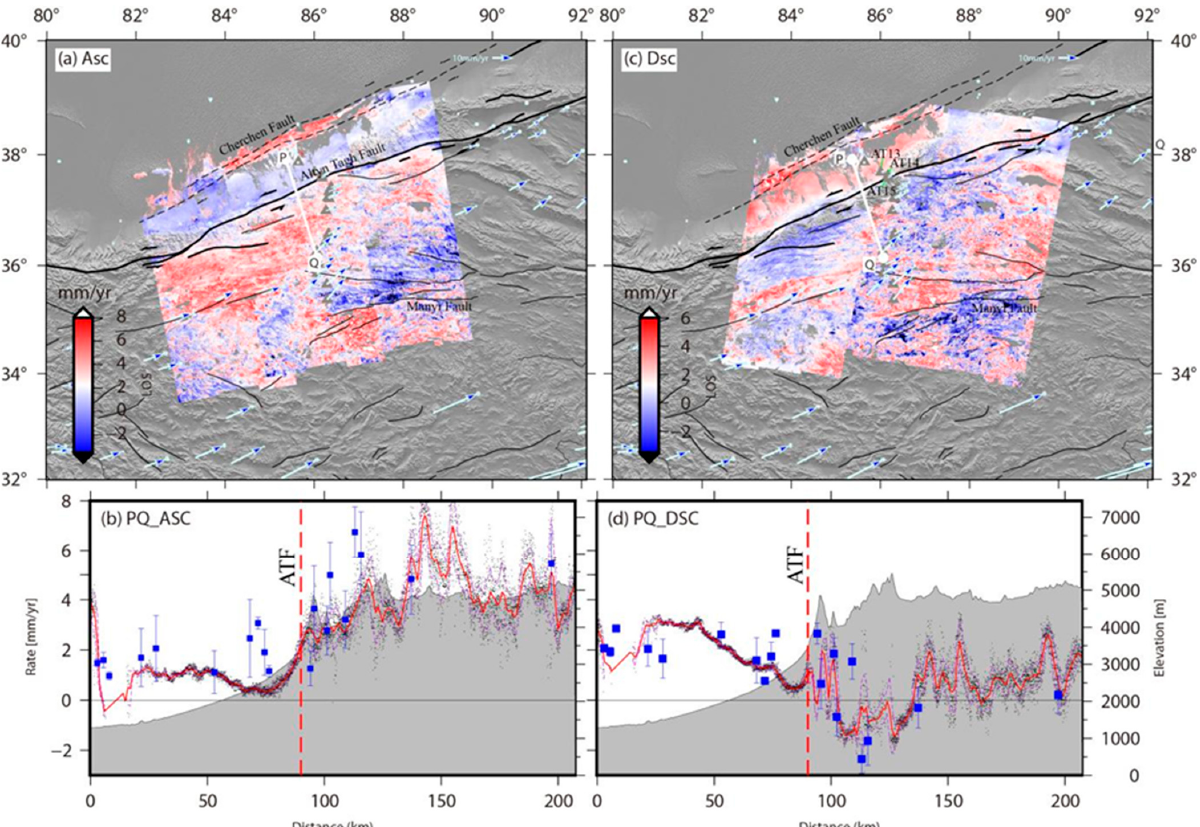
Figure 3. Line-of-sight (LOS) velocities on ( a ) ascending (mosaic of tracks 85, 12, and 114) and ( c ) descending (mosaic of tracks 92, 19, and 121) tracks. The solid white line indicates the position of the velocity profile. Negative (blue) and positive (red) values indicate relative motion towards and away from the satellite, respectively. ( b , d ) Ascending and descending LOS velocity along with PQ profiles across the ATF. Red dashed lines represent the ATF. The blue squares with error bars are the velocities projected into LOS within 100 km of the fault crossing profiles. The scattered points show InSAR LOS velocities within a 10 km perpendicular distance from the profiles. The solid red lines mark binned mean along with profiles. Grey shaded areas are topographic profiles along the PQ line from DEM.